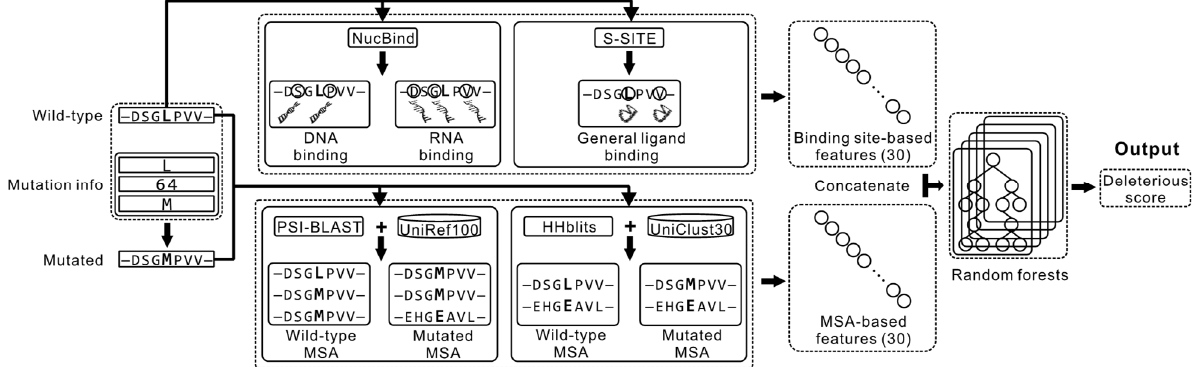
Figure 1. The architecture of the proposed DMBS method. The inputs to DMBS include the wild-type sequence and the mutation information (wild-type residue, mutated position and mutated residue). The wild-type sequence is submitted to two sequence-based binding site prediction methods, NucBind and S-SITE, to predict DNA/RNA and general ligand binding sites, respectively. Meanwhile, both the wild-type and the mutated sequences are searched against two sequence databases (UniRef100 and UniClust30) with two algorithms (PSI-BLAST and HHblits, respectively) to construct four MSA profiles. A total of 60 features are extracted from the predicted binding site information and the MSA profiles, which are fed into the random forests algorithm to predict the deleterious score of the mutation.